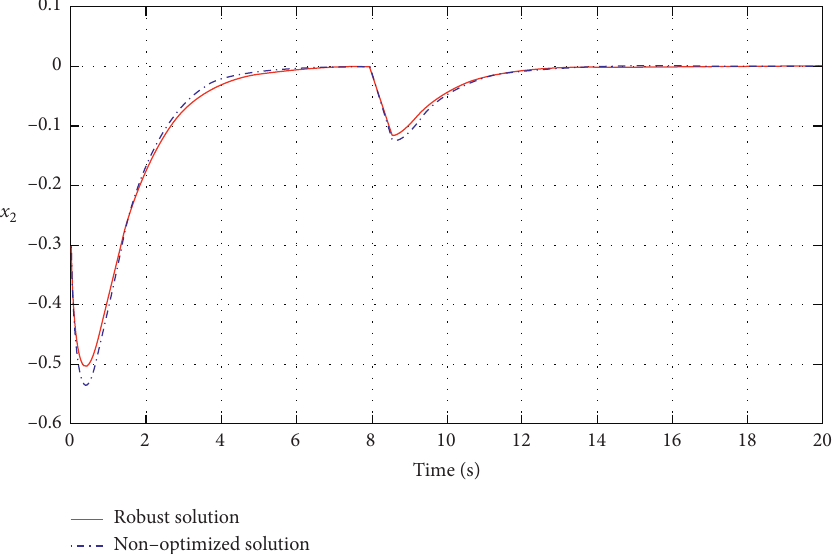
between robust solution and nonoptimized solution. 1